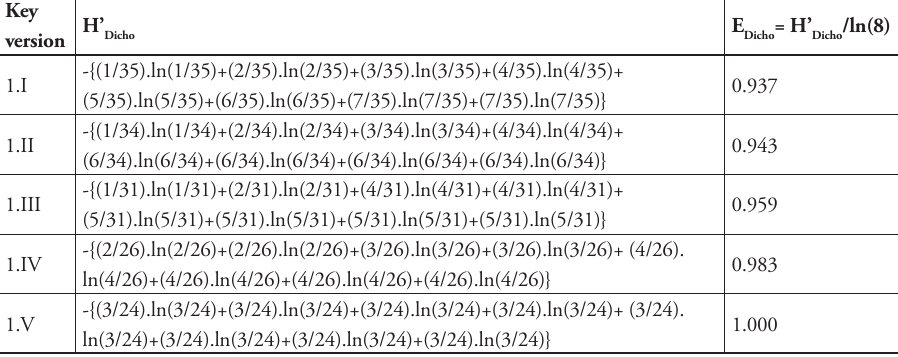
and E Dicho dicho